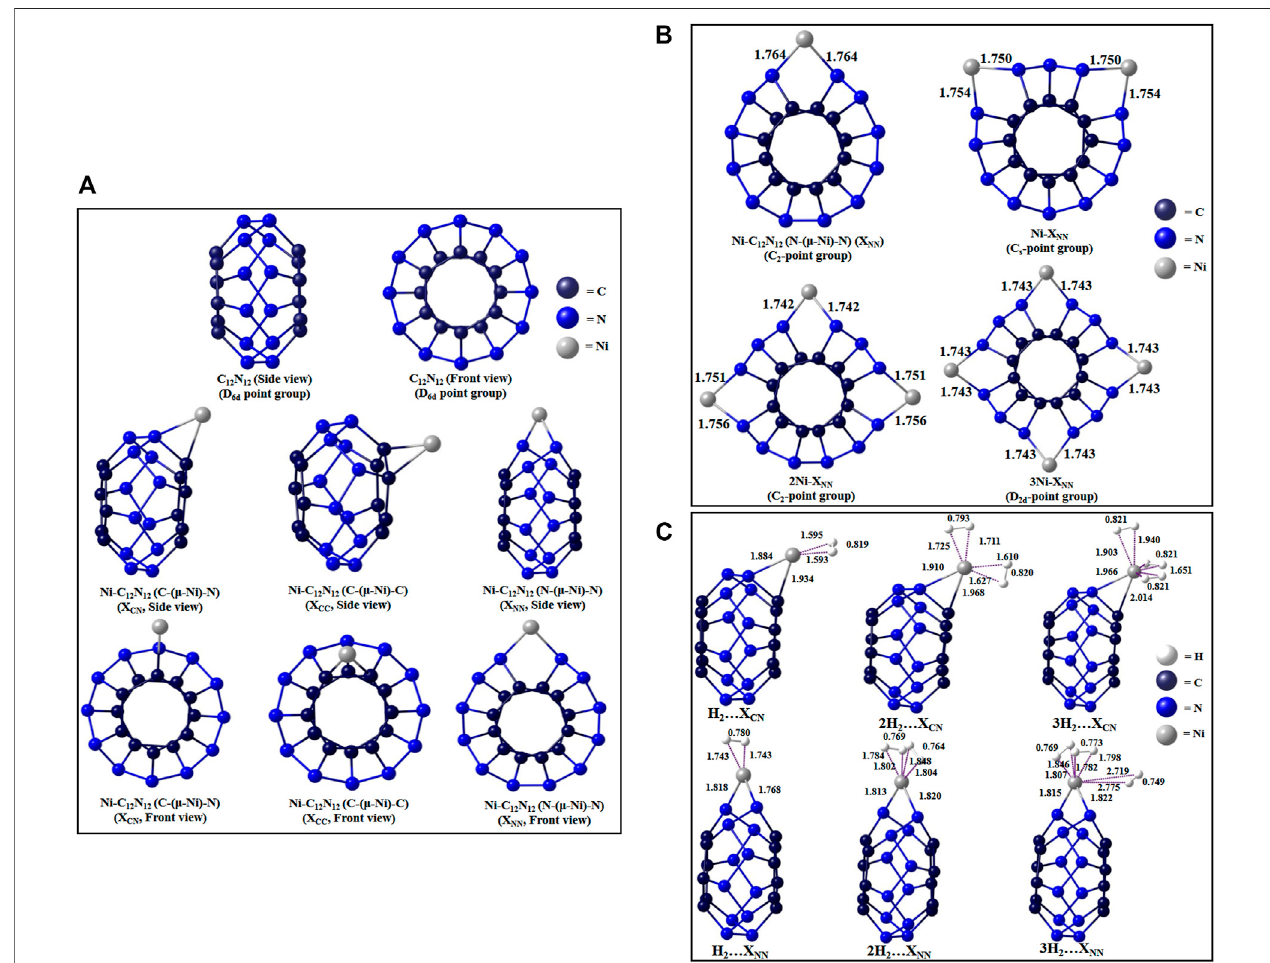
FIGURE11| Optimizedstructuresof (A) C 12 N 12 anditsthreeNi-boundisomers, (B) nNi-decoratedC 12 N 12 , (C) H 2 -trappedsingleNi-boundC 12 N 12 clustersat ω B97X- D/Def-TZVP level. (Reproduced from Jana et al., 2020 with permission from VBRI Press. Copyright ©2010 – 2021 VBRI Press)